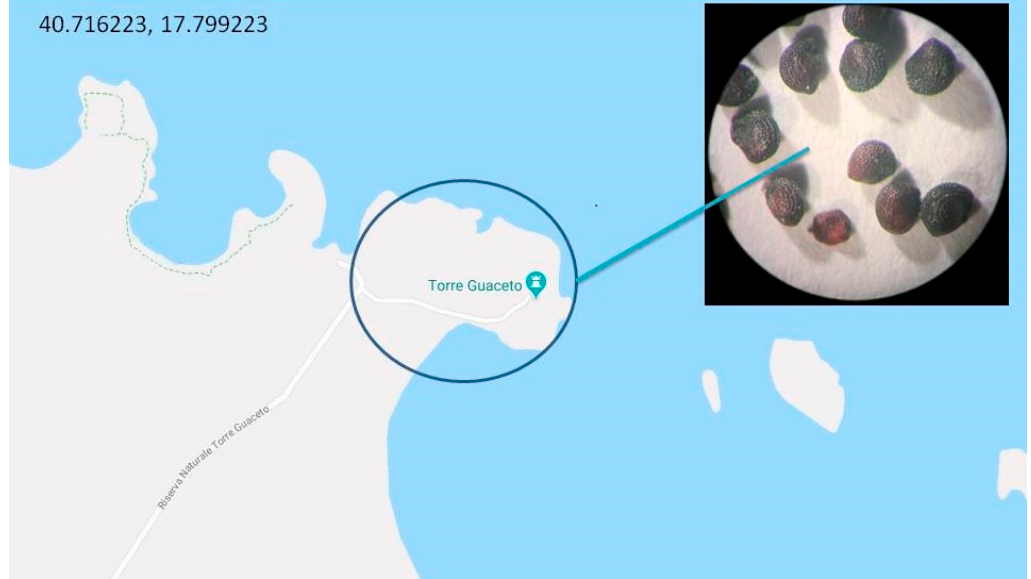
Figure 2. Sarcocornia sp. seeds gathered from Torre Guaceto (Province of Brindisi, Apulia, Italy).